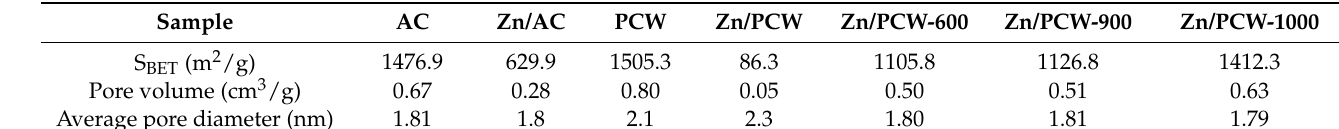
Table 1. Physical-chemical properties of the different catalysts.